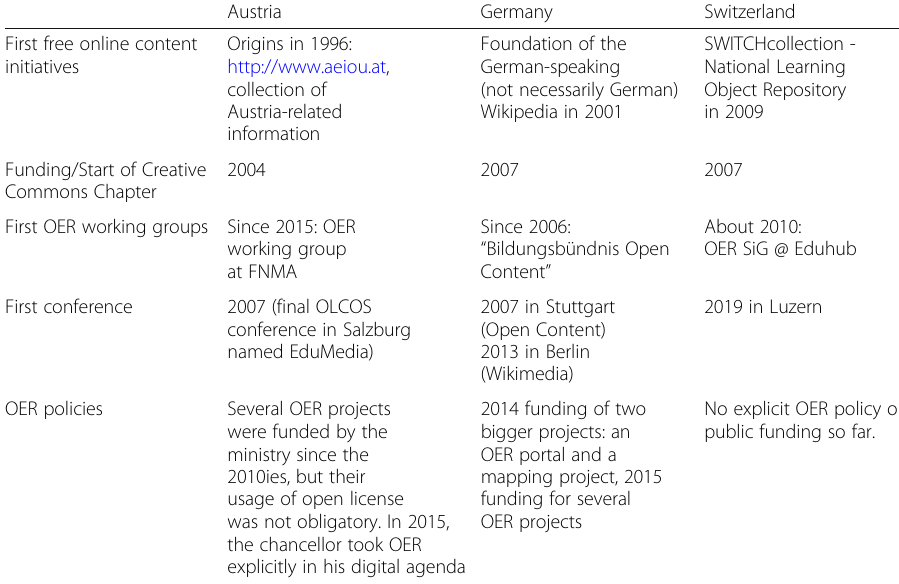
Table 1 Milestones in OER-related developments in Austria, Germany and